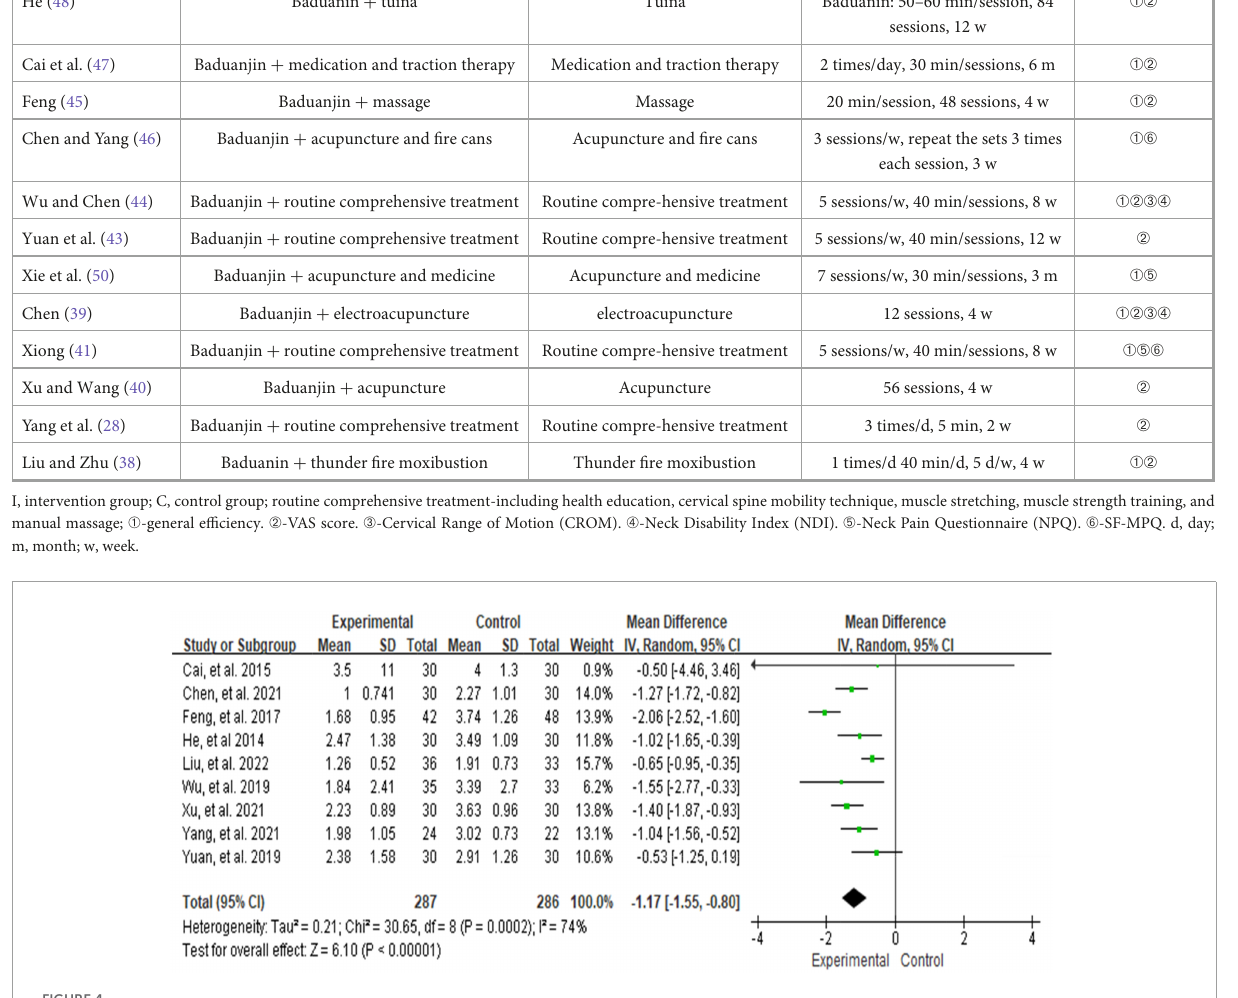
FIGURE4 Analysis chart of comparison of VAS